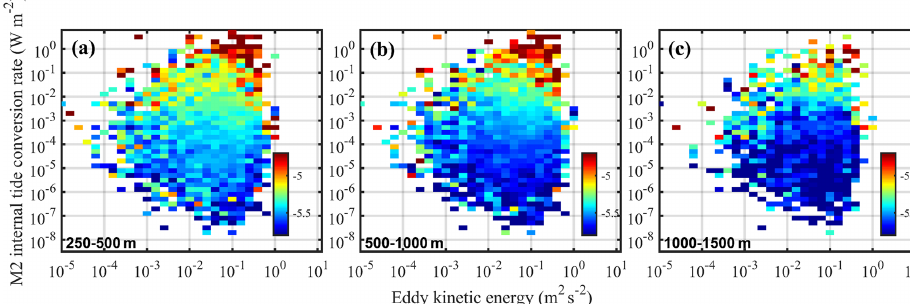
Figure 8. Averaged diapycnal diffusivities as a function of EKE and internal tide conversion rates between (a) 250–500m, (b) 500–1000m, and (c) 1000–1500m.